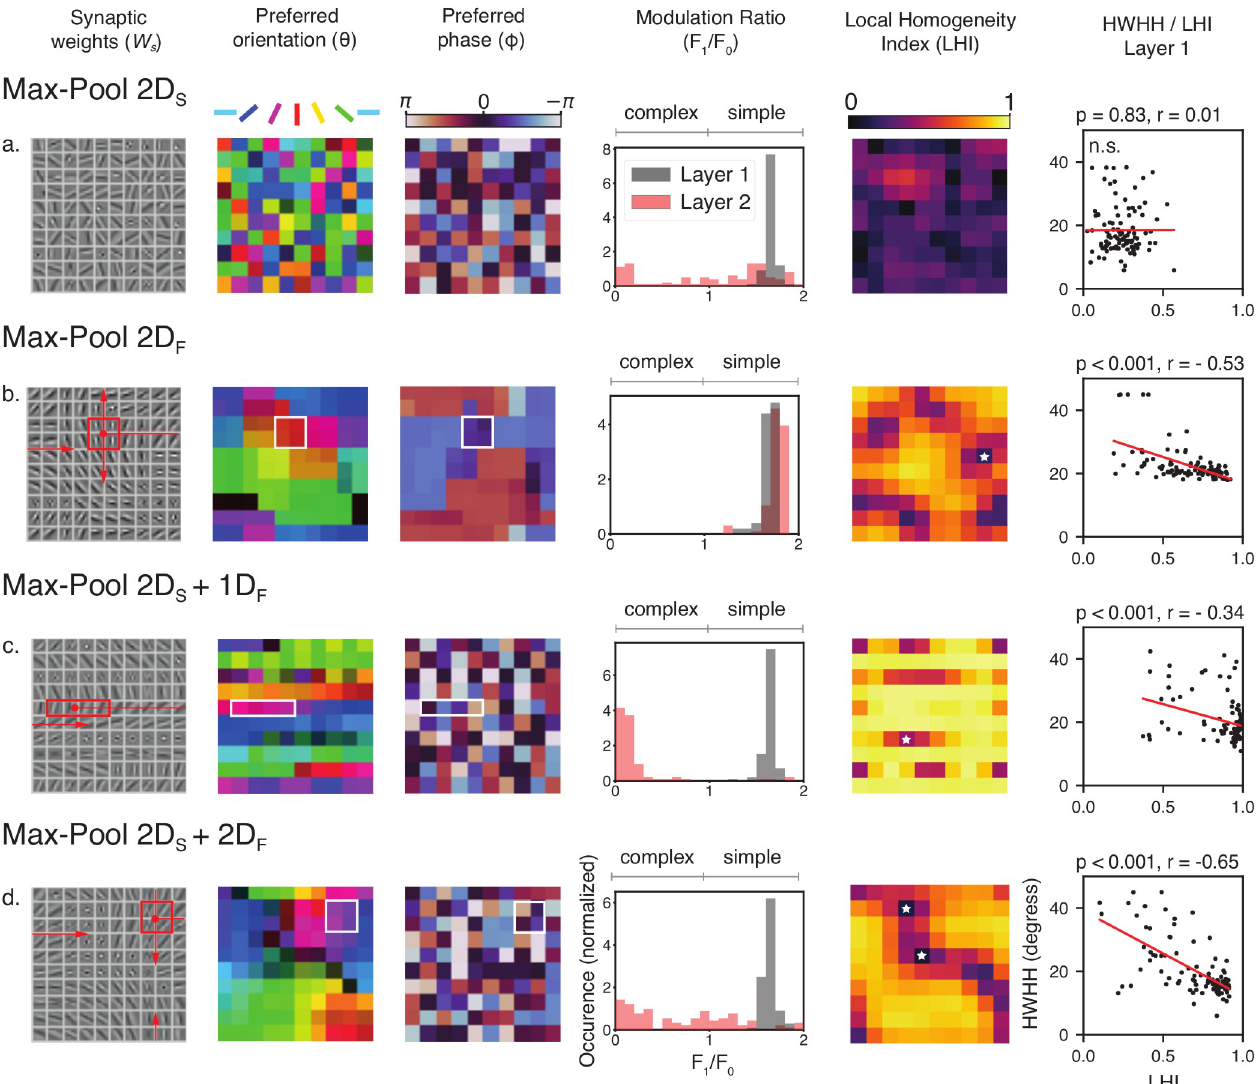
Fig 3. Emergence of orientation maps in the first layer and complex response in the second layer. We show the different properties learned by our model depending on which pooling functions we used ( a — d ). All networks showed here are trained with M simple cells Receptive Fields (i.e. the synaptic weights of the first layer W s ). The red rectangles for ( b — d ) indicate the size of the feature pooling, the red arrows illustrate the circular ( c ) or toroidal ( b and d ) structure of the feature space. Second column . Orientation preference of each neuron represented by the filters in W . The luminance of the map is modulated by the orientation selectivity (HWHH) of each neuron. Third column . Phase preference of each neuron s represented by the filters in W s . Fourth column . Distribution of the modulation ratio ( F 1 homogeneity index (LHI) associated with each element is W s . White stars indicate the position of pinwheels. Sixth column . Linear relationship between the LHI and the orientation selectivity, measured by the half-width at half-height (HWHH) of the response of cells from the first layer.